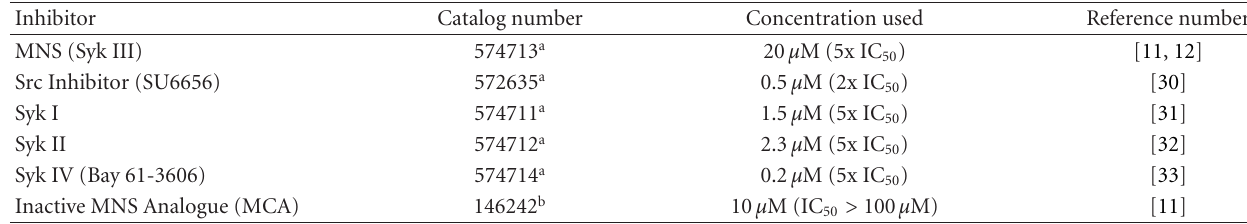
Table 1: Small molecule inhibitors and inactive MNS